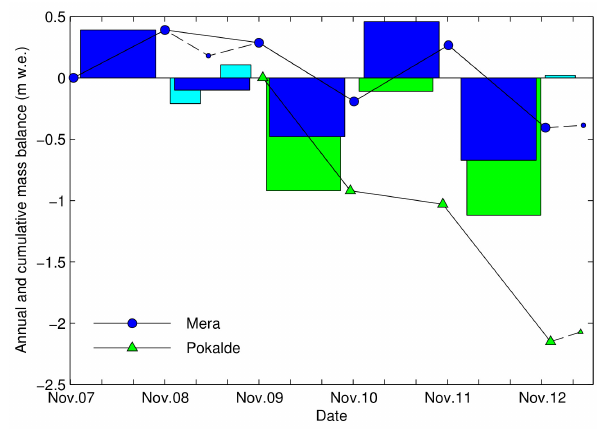
Fig. 6. Annual (dark blue and green large histograms) and cumula- tive (line with big blue dots and line with big green triangles) mass balances of Mera Glacier and Pokalde Glacier respectively. Also shown are the winter (November to April) and summer (April to November) mass balances for 2008–2009 and 2012–2013 (narrow cyan histograms – only Mera Glacier is represented) and the cor- responding cumulative mass balances (dashed line with small blue dots for Mera Glacier and dashed line with small green triangles for Pokalde